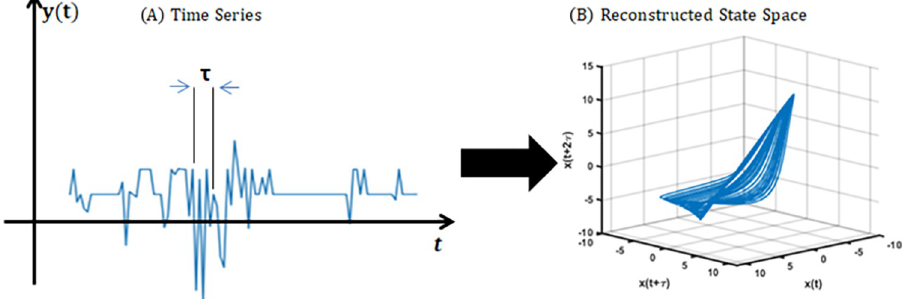
Fig 1. State Space Reconstruction (SSR) concept ( τ = time